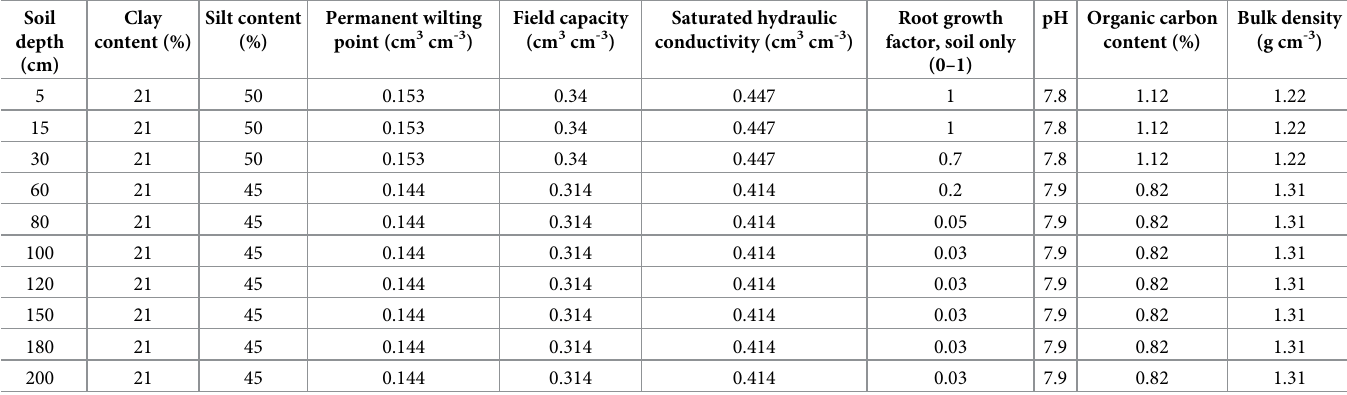
Table 5. Physical and chemical properties of the